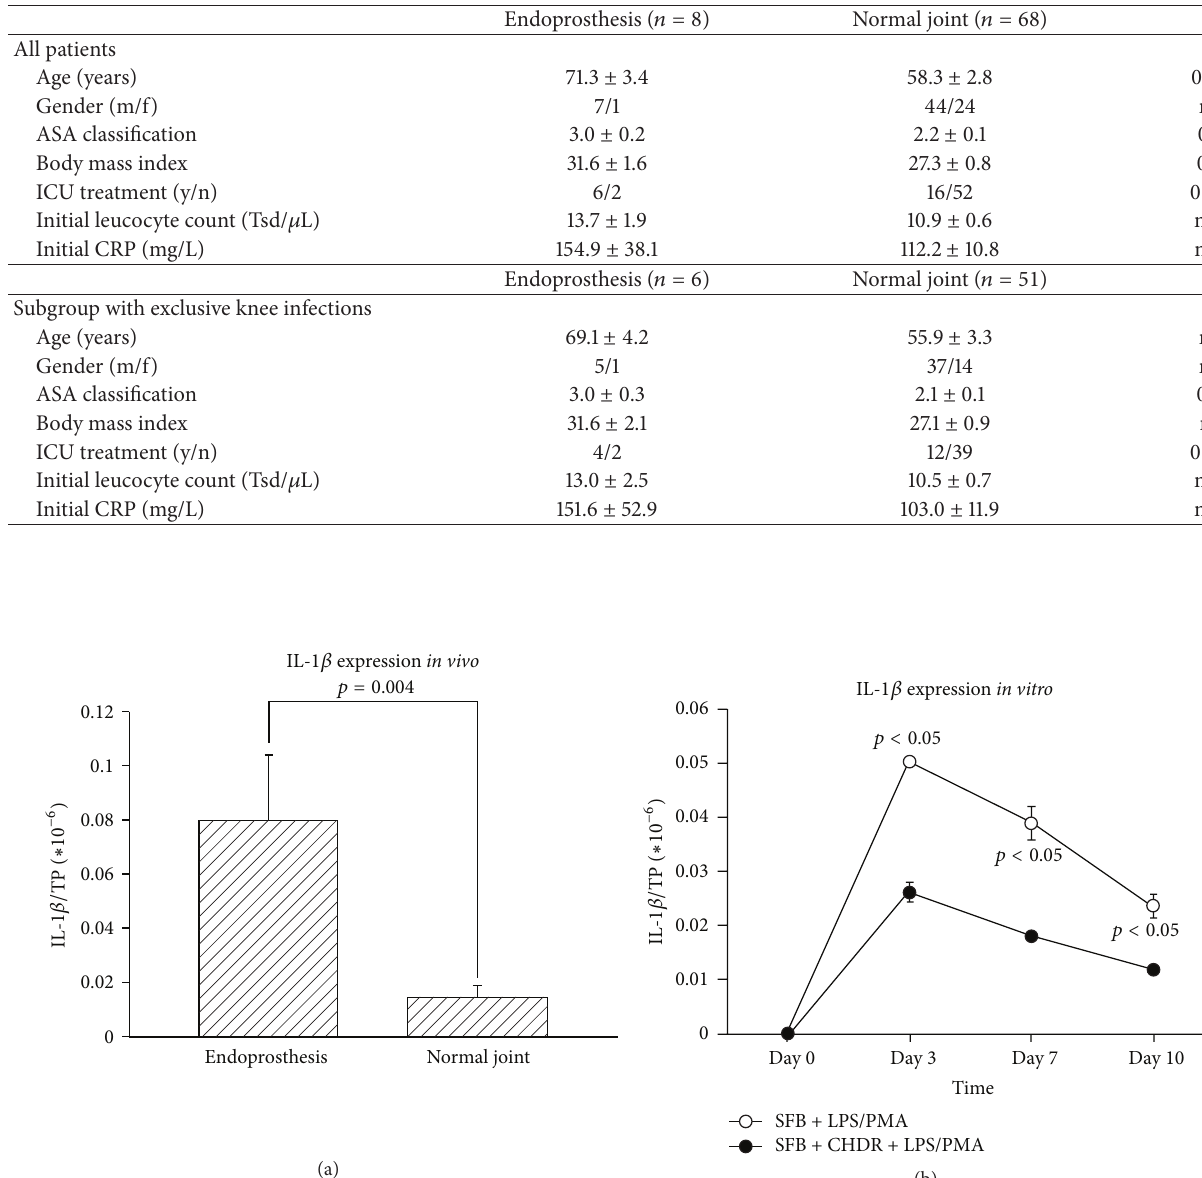
Table 1: Comparison of patients with arthroplasty and normal joints using epidemiological and inflammatory parameters. The first data set shows the comparisons for all patients, the second for the subgroup of patients with exclusive knee infections and knee arthroplasties. m: male, f: female, ASA: physical status according to the American Society of Anesthesiologists, ICU: intensive care unit, y: yes, n: no, and CRP: C-reactive protein in serum. ∗ Aspin-Welch test, + Chi square test, # 𝑈 -test (Mann-Whitney), and ++ 𝑡 -test.